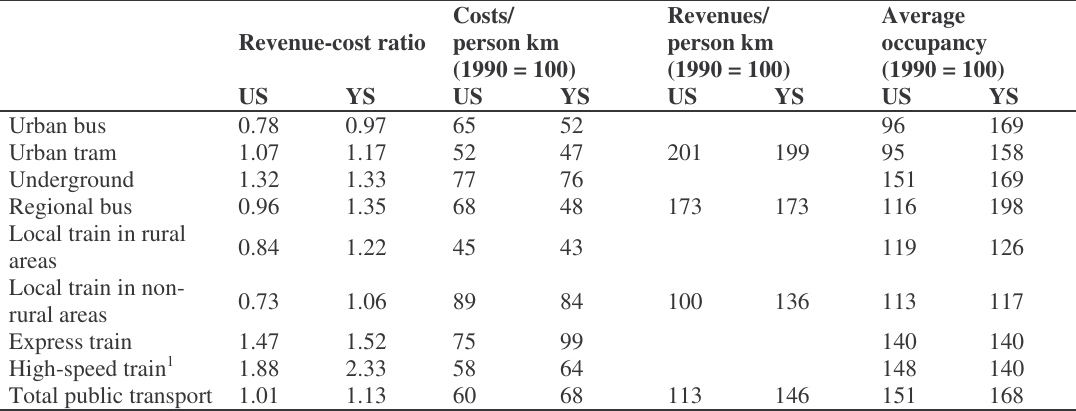
Table 7. The financial performance of public transport in the scenarios